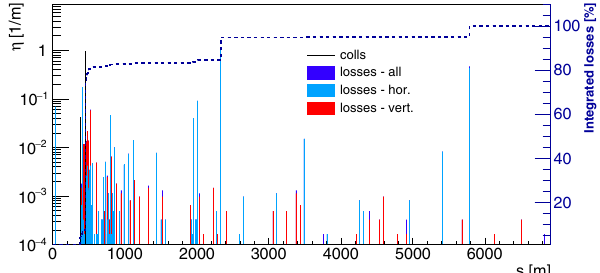
FIG. 9. Local cleaning inefficiency for the measured aperture and with tighter collimation cuts ( 4 σ β þ 0 . 9 D x δ at the primary p ; bh stage, 4 . 5 σ β þ 0 . 9 D x δ at the secondary stage). p ; bh